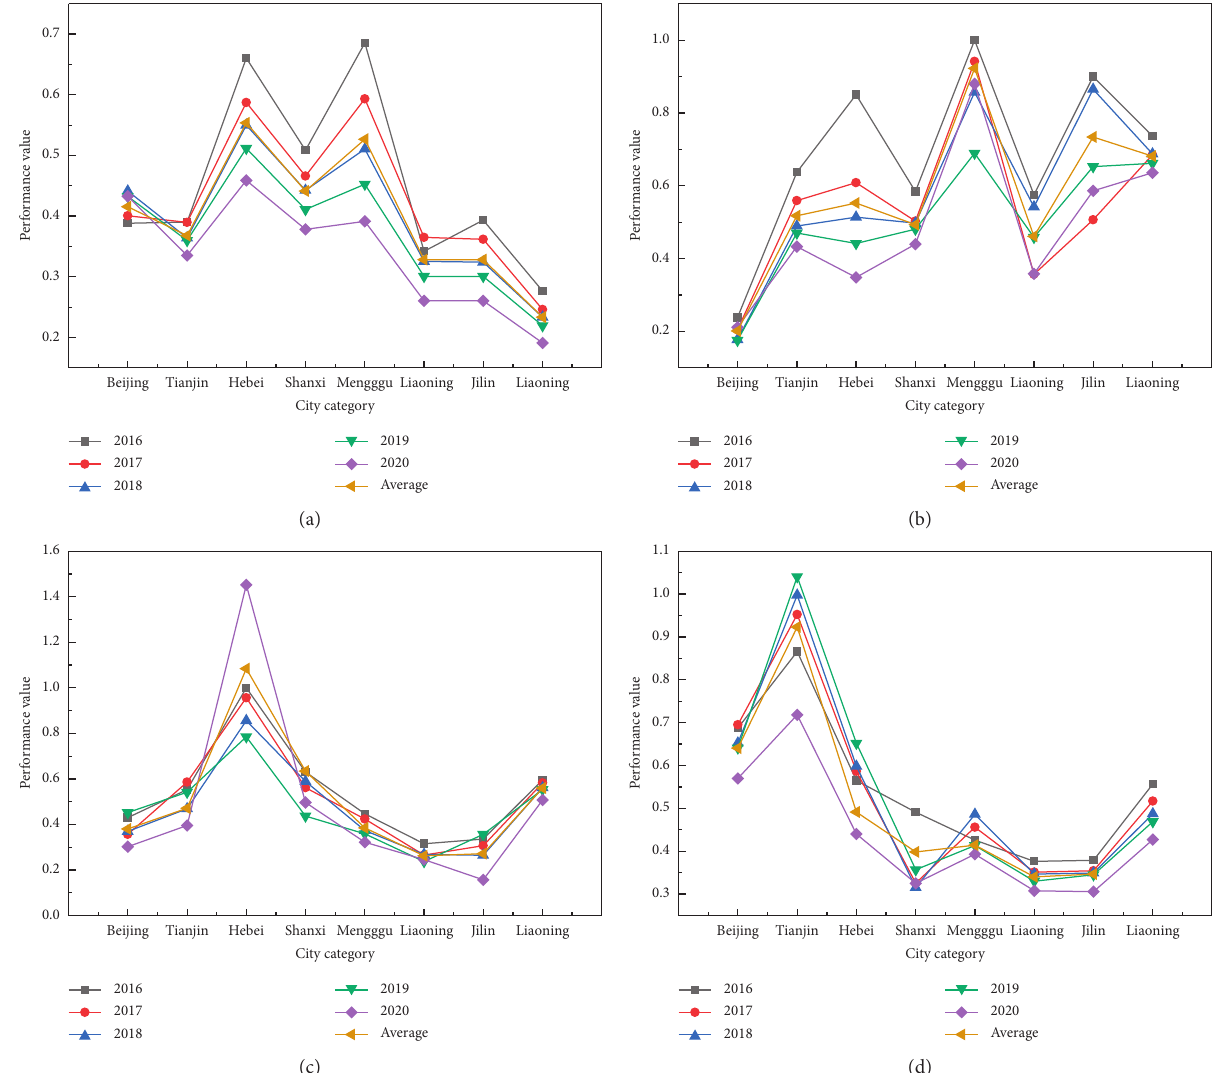
Figure 1: Comparison of performance value evaluation in different regions. (a) National average. (b) Eastern region. (c) Central region. (d) Western